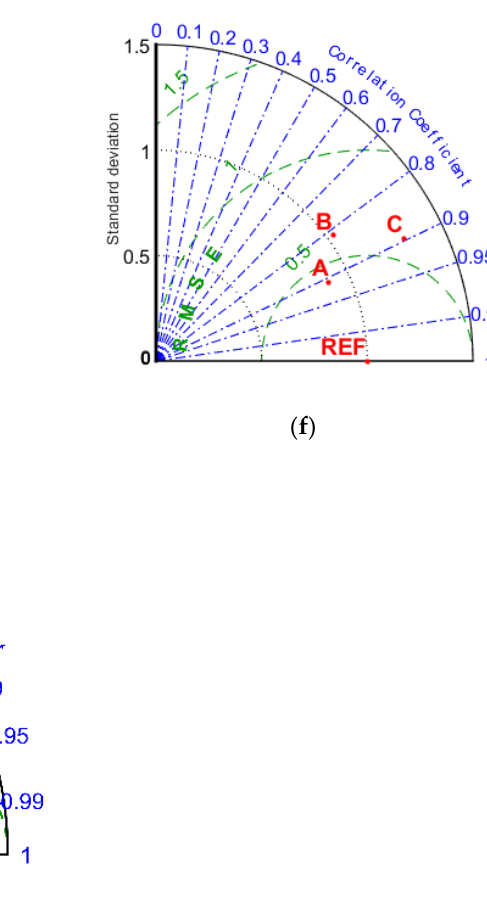
Years/Parameters